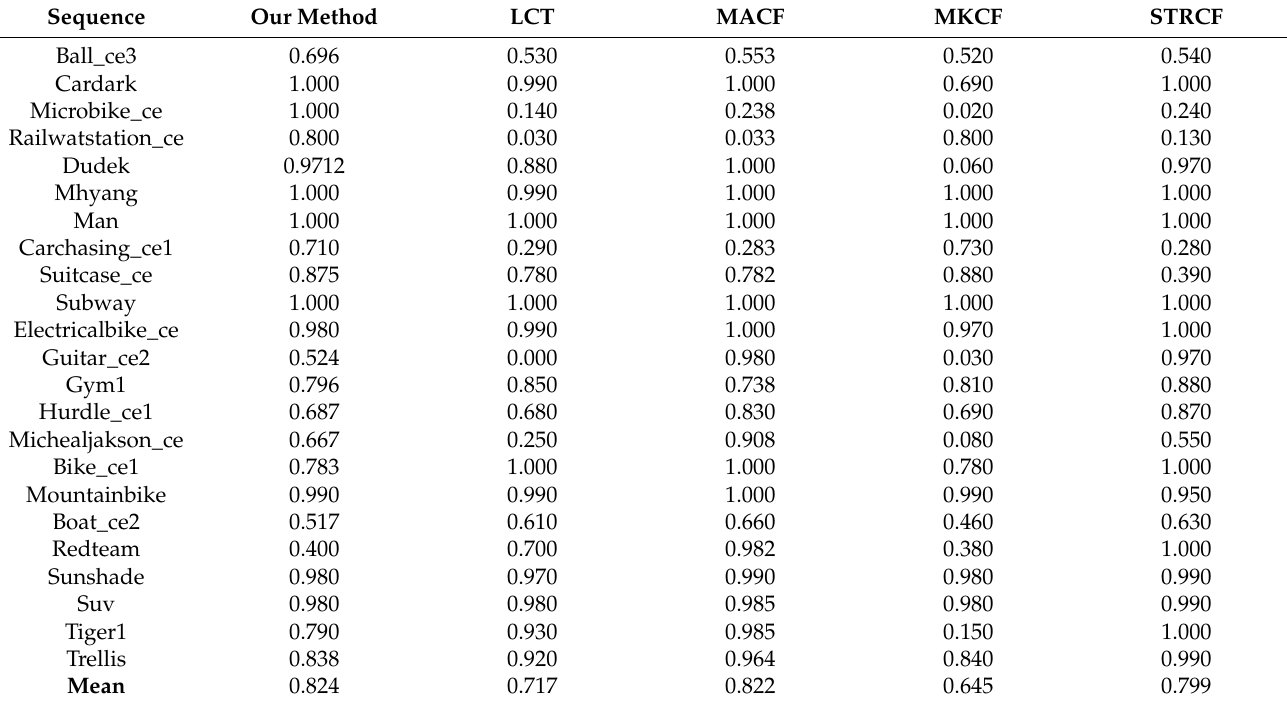
Table 5. Overlap success rate comparison of proposed tracking scheme with four other tracking